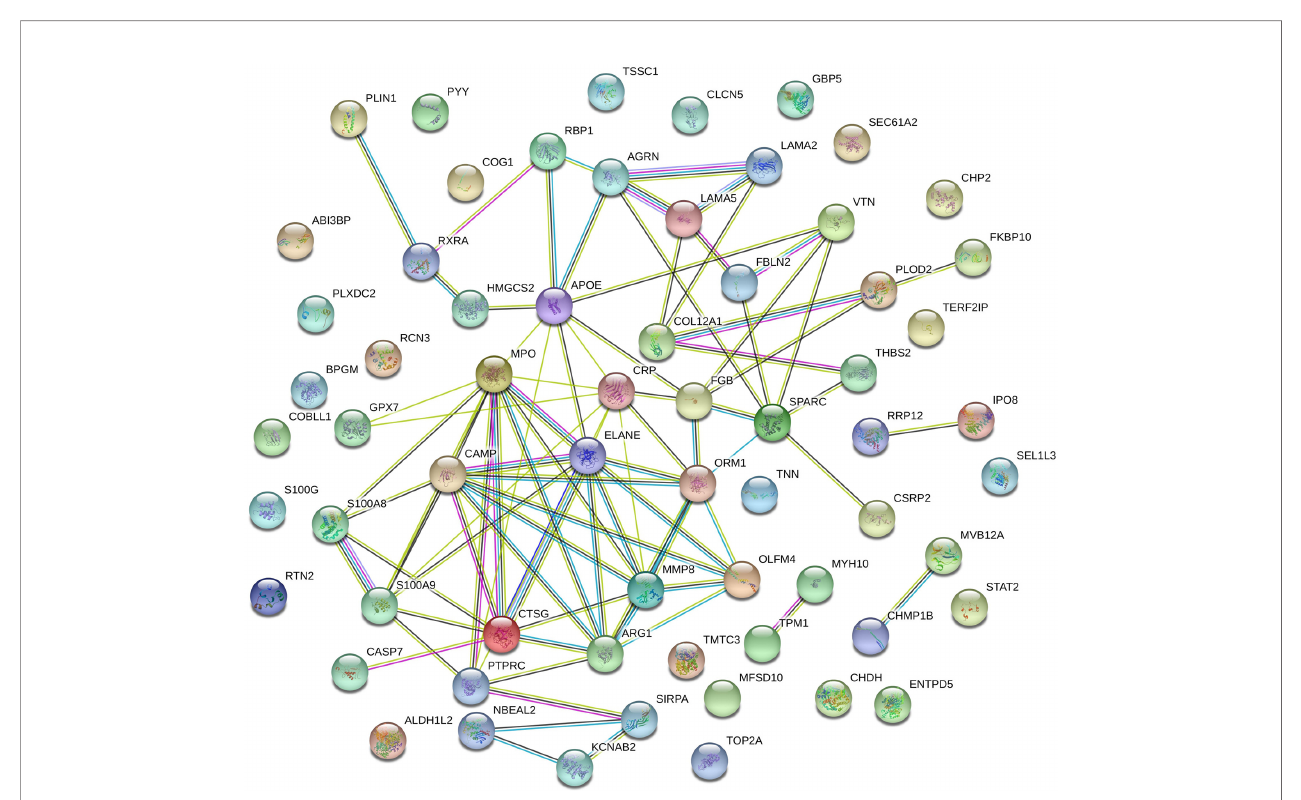
FIGURE 5 | Protein – protein interaction network of SNT-related differentially regulated proteins that may indicate the ef fi cacy of SNT against UC. Each node represents all the proteins produced by a single protein-coding gene locus. Edges represent protein – protein interactions: red line — fusion evidence; green line — neighborhood evidence; blue line — co-occurrence evidence; purple line — experimental evidence; yellow line — text mining evidence; light blue line — database evidence; black line — coexpression